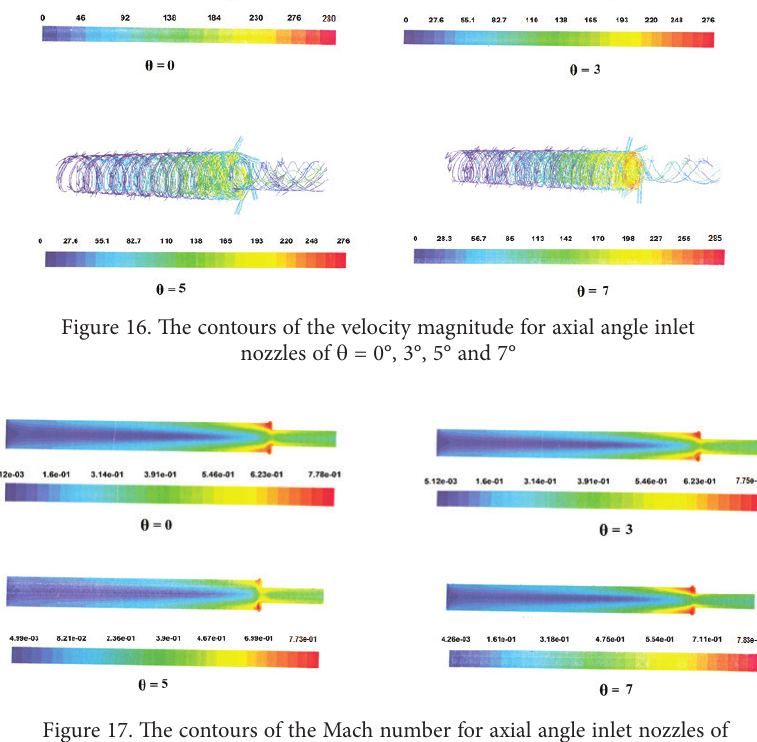
Figure 17. The contours of the Mach number for axial angle inlet nozzles of θ = 0°, 3°, 5° and